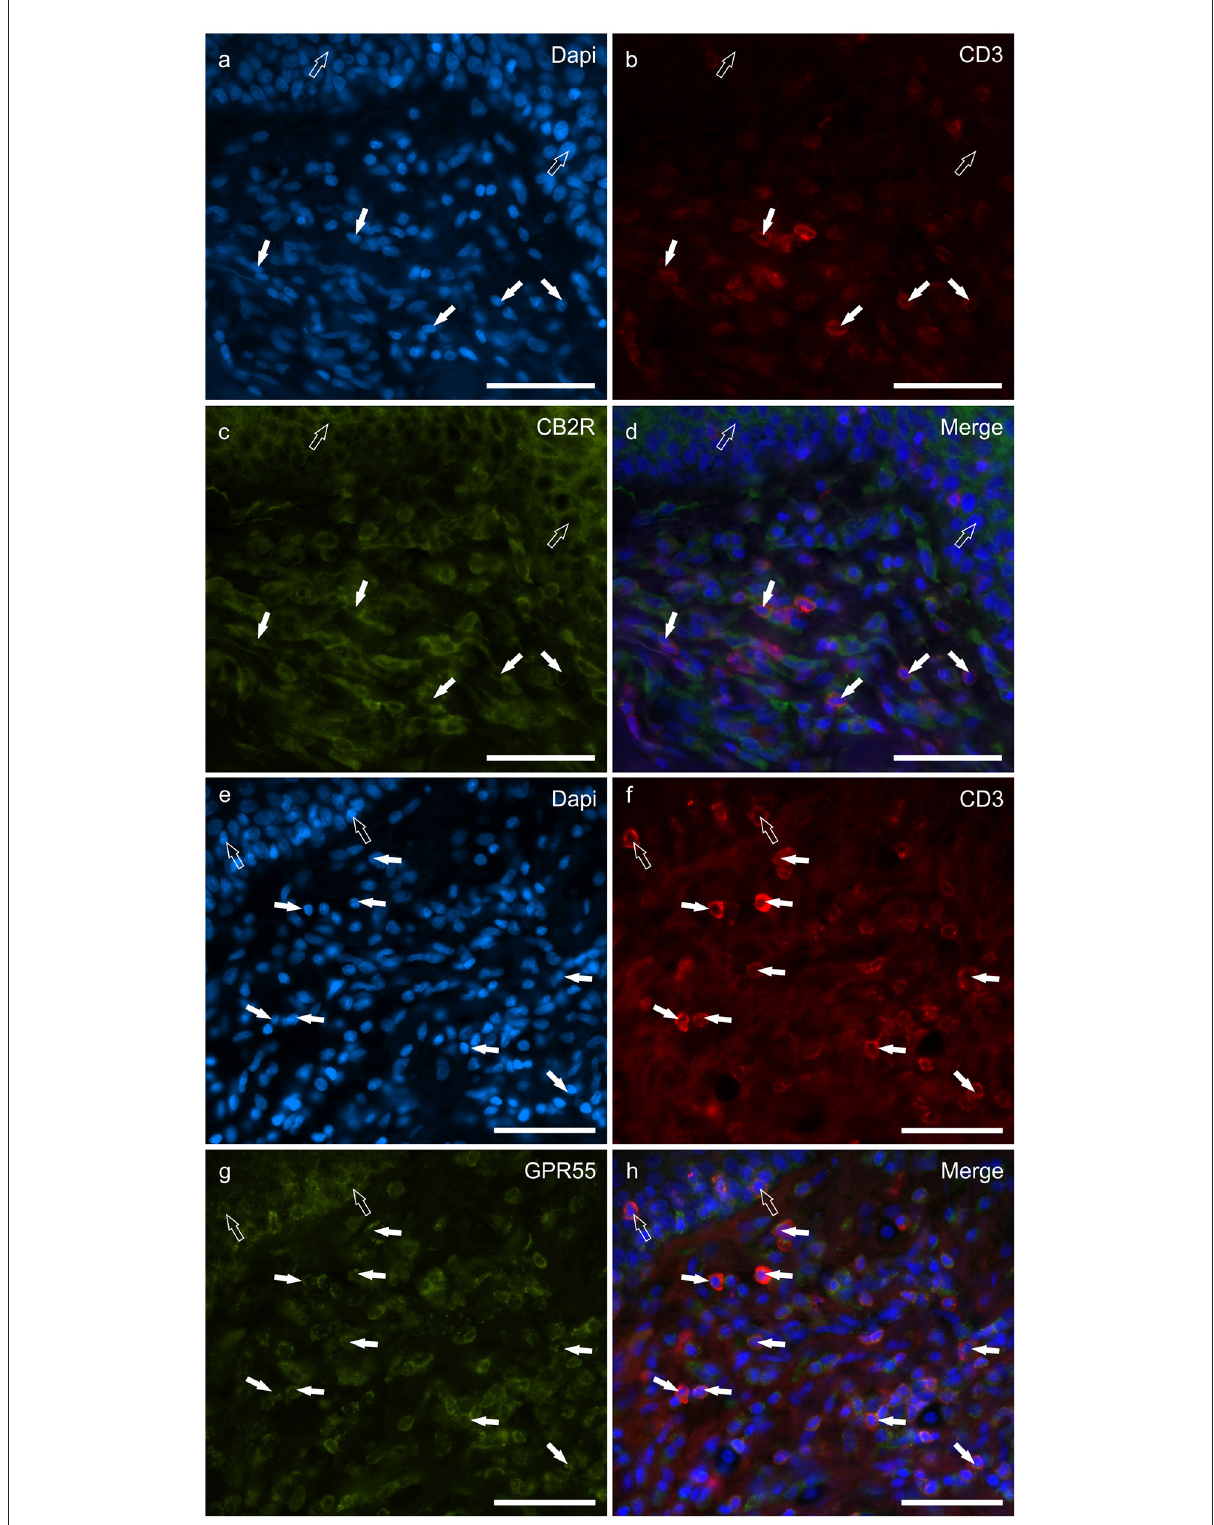
FIGURE6 Photomicrographs of the cryosections of the skin of dogs with atopic dermatitis (AD) showing CD3 immunoreactive T lymphocytes expressing cannabinoid receptor 2- (CB2R) (a–d) and G-protein coupled receptor 55- (GPR55) (e–h) immunoreactivity (IR) (e–h) . (a–d) The white arrows indicate the Dapi-labeled nuclei of some CD3 immunoreactive T lymphocytes co-expressing CB2R-IR. The open arrows indicate the nuclei of